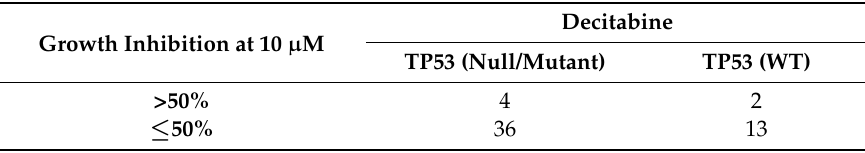
Table 3. Allocation of cell lines of NCI 60 cell line panel treated with decitabine by growth inhibition at 10 µ M and TP53 status.